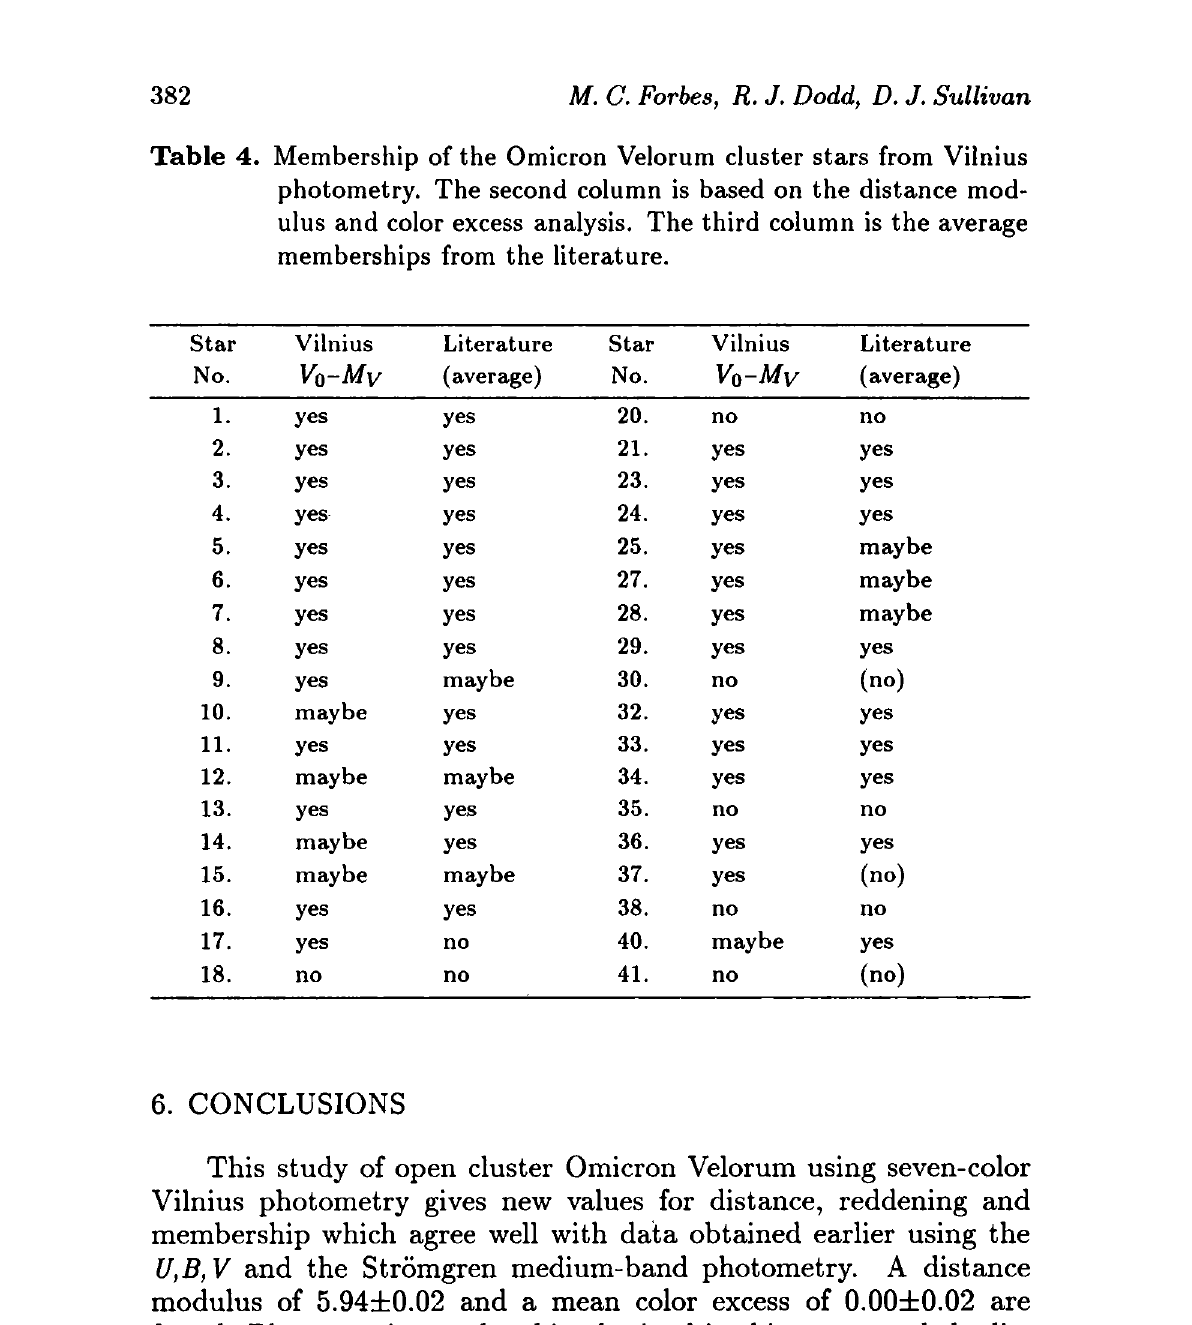
Table 4. Membership of the Omicron Velorum cluster stars from Vilnius photometry. The second column is based on the distance mod- ulus and color excess analysis. The third column is the average memberships from the